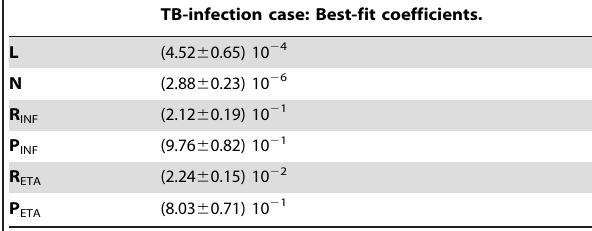
TB-infection case: Best-fit coefficients.